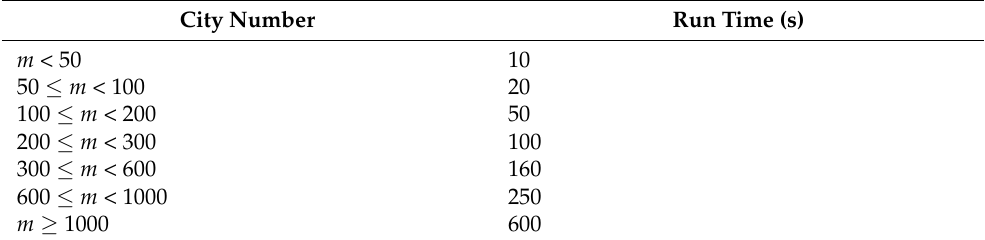
Table 4. The maximum iteration times with different city